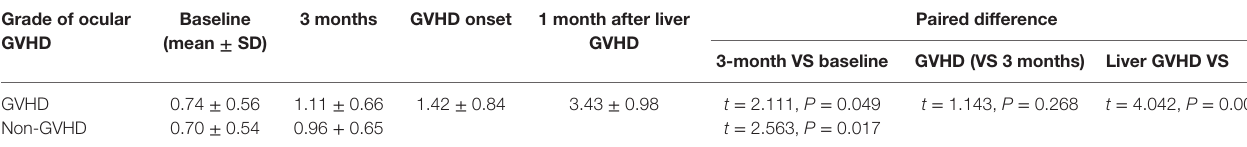
Table 5 | compare the score of ocular graft-versus-host disease (gVhD) between gVhD and non-gVhD